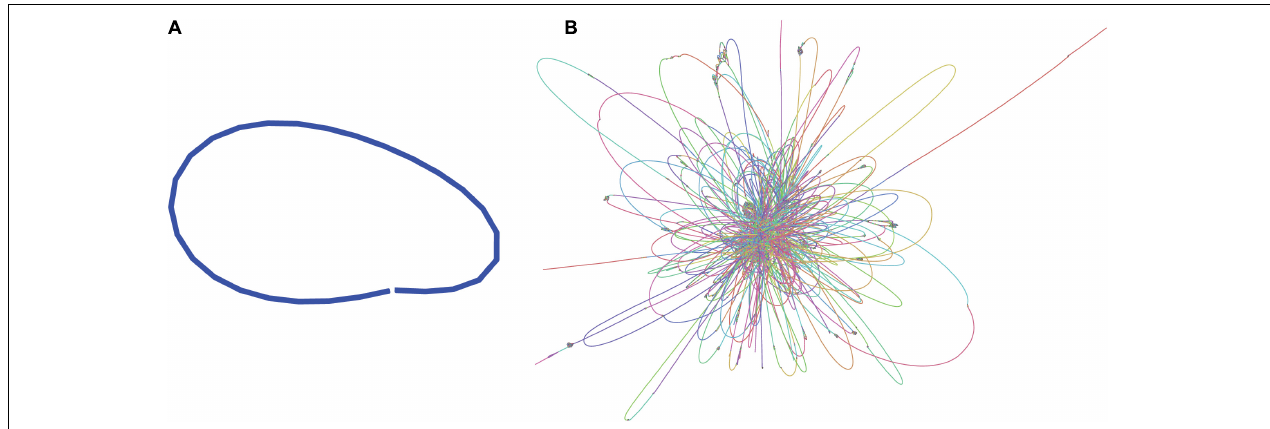
FIGURE 1 | Assembly graphs of L. fusiformis assemblies using (A) nanopore data (Shasta), (B) illumina data (SPAdes) (images generated using Bandage: Wick et al., 2015).